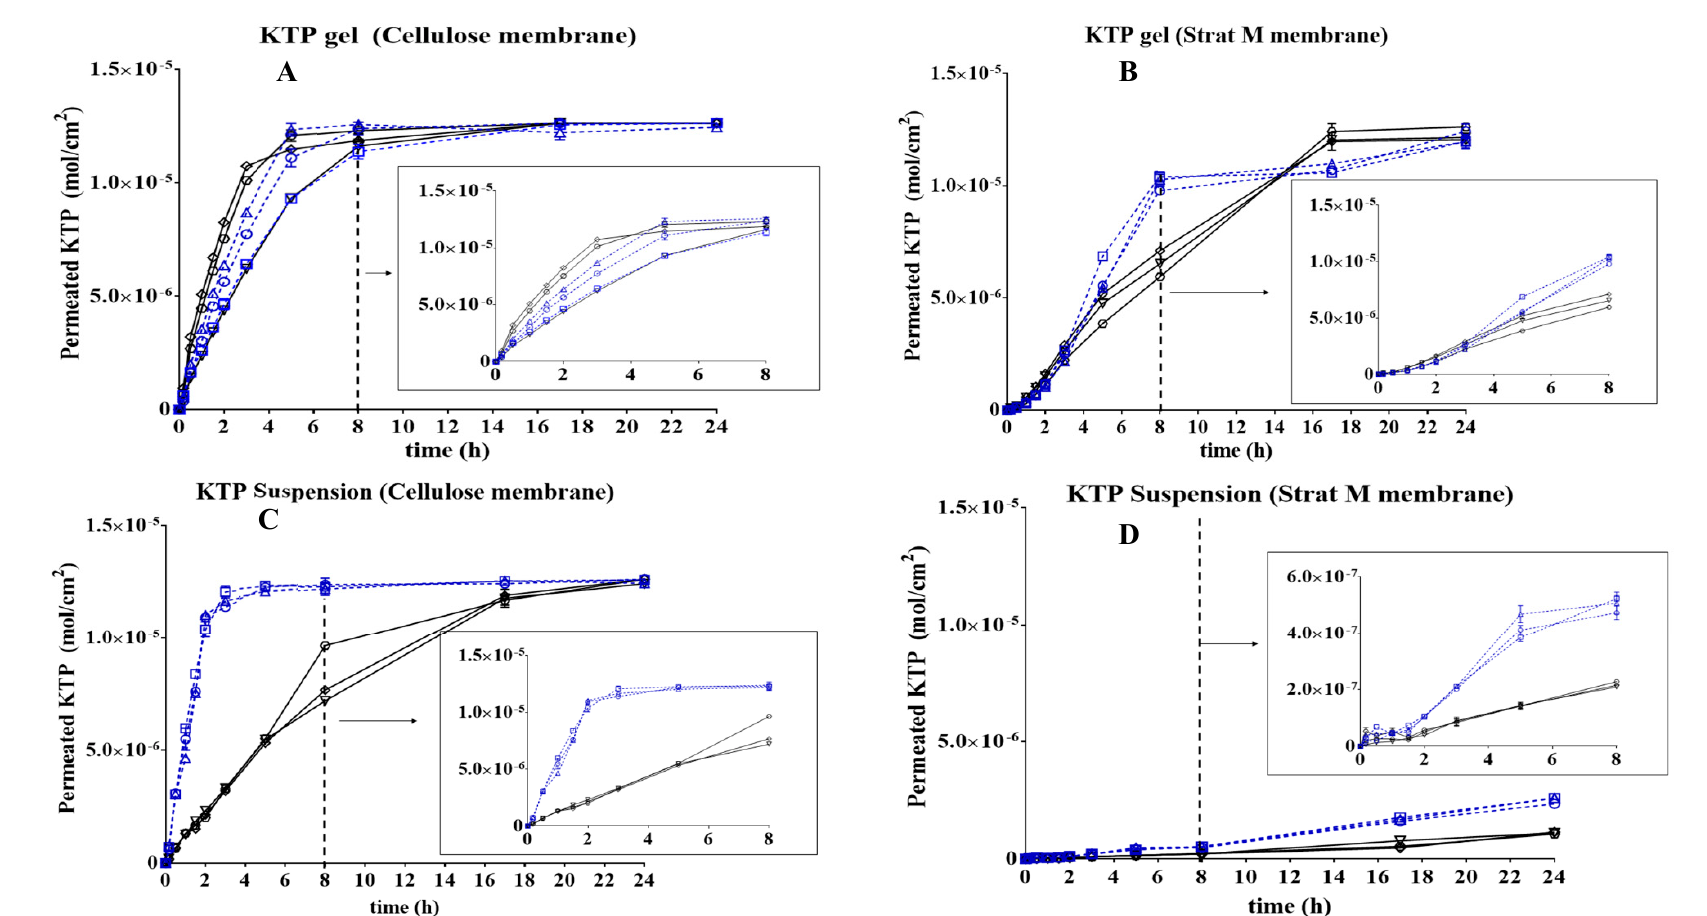
Figure 1. Permeation profiles of ketoprofen (KTP) for 24 h in different conditions of matrix, medium, pH and type of membrane. ( A ) KTP Gel-cellulose membrane, ( B ) KTP Gel—Strat M ® membrane, ( C ) KTP Suspension—cellulose membrane, ( D ) KTP Suspension—Strat M ® membrane. Graph legends: = Cell A. pH: 5.6; = Cell B. pH: 5.6; = Cell C. pH: 5.6; = Cell A. pH: 7.4; = Cell B. pH: 7.4; = Cell C. pH: 7.4.